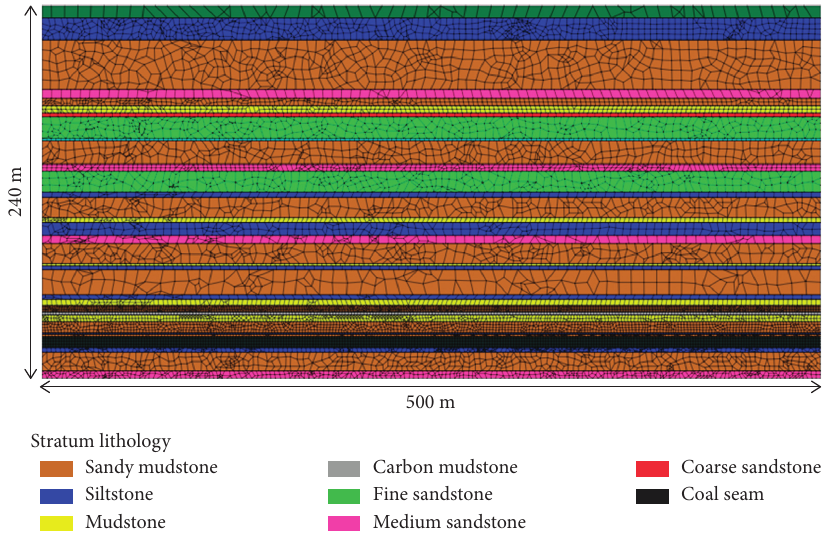
Figure 6: Numerical model of the 4203 LTCC panel. Table 1: Physical and mechanical properties of the